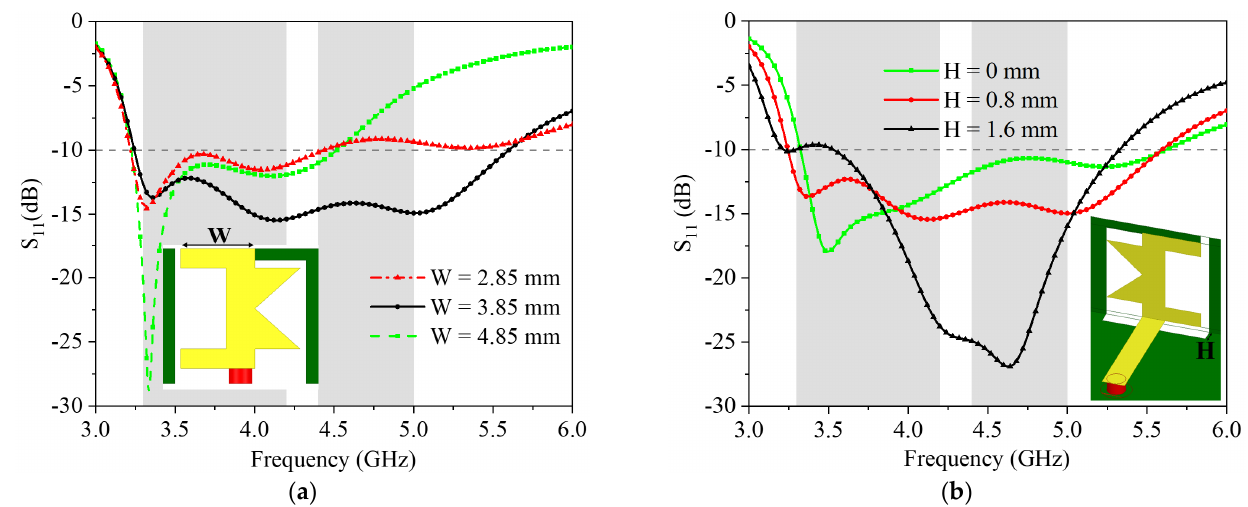
Figure 4. The simulation results of S 11 with unequal values of ( a ) W; ( b ) H. The simulated transmission coefficients of the presented antenna with or without